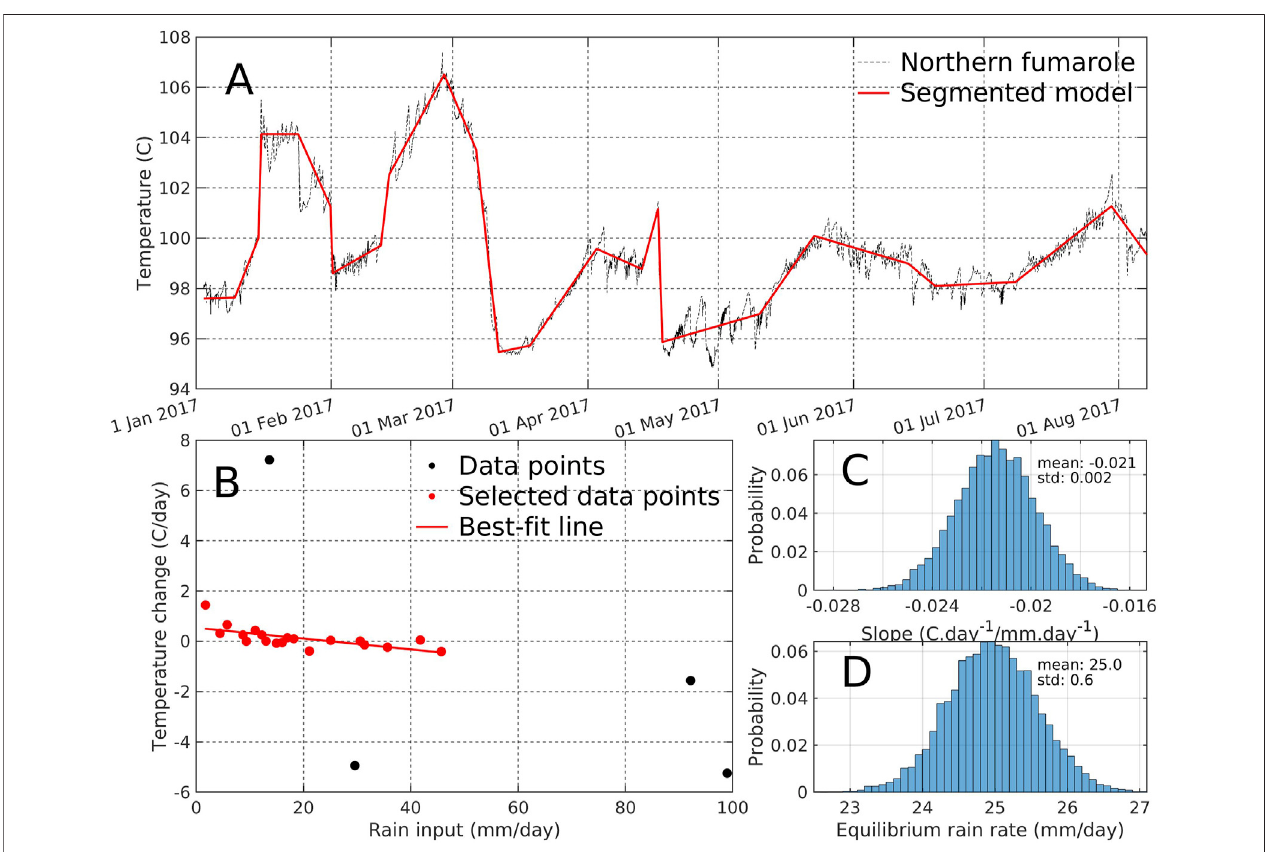
FIGURE5| Correlationbetweenlong-periodtemperaturevariationsattheNSCventandtheinputofmeteoricwater (A) TemperaturetimeseriesatNSC(thinblack line) and its segmented optimal approximation (red solid line) (B) Correlation between the mean rain input during each linear segment of the red line in (A) and the temperature drift (i.e. slope of the linear segment). Outliers in black are not taken into account for calculating the best- fi t line (C) Probability distribution of the bootstrapped slope of the best- fi t line in B (D) Probability distribution of the bootstrapped intercept of the best- fi t line in B with the horizontal axis. This “ equilibrium rain rate ” corresponds to the amount of meteoric water input required to obtain a constant steam temperature at the fumaroles.